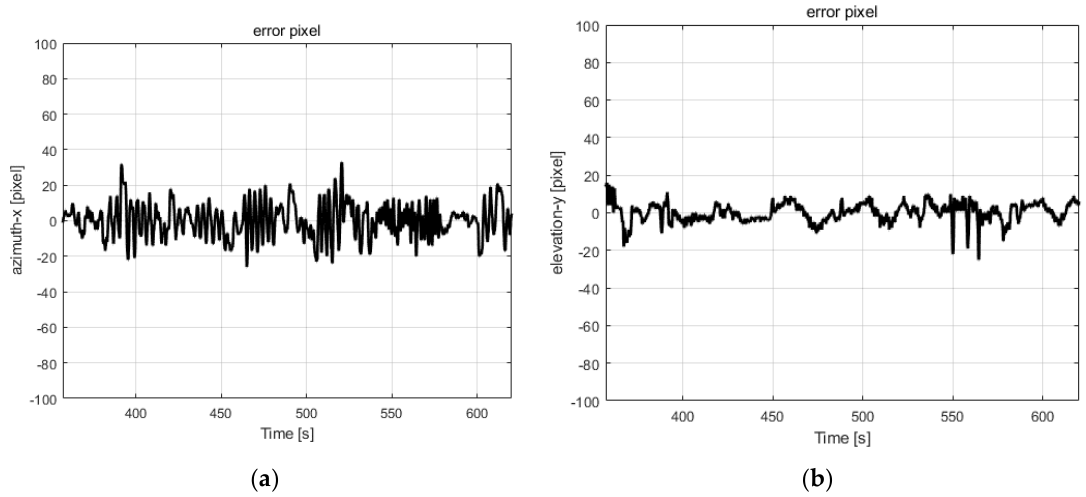
Figure 17. Boresight error in pixels while the UAV is following a human target moving at pedestrian speed. ( a ) the response in azimuth; ( b ) the response in elevation.